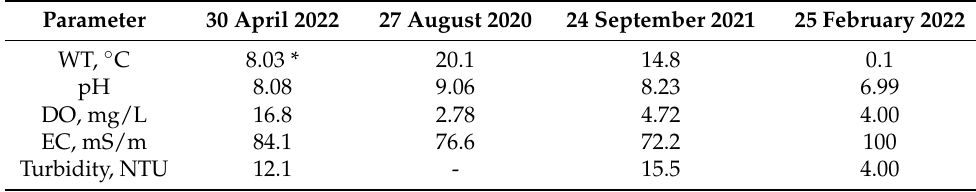
Table 2. Water quality characteristics of surface lake water at Bulan 2 station.